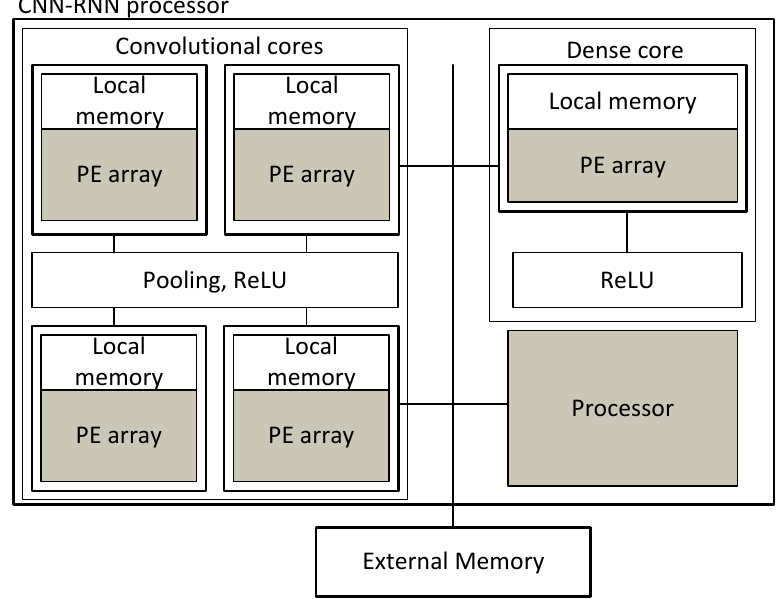
Figure 6. Reconfigurable architecture of